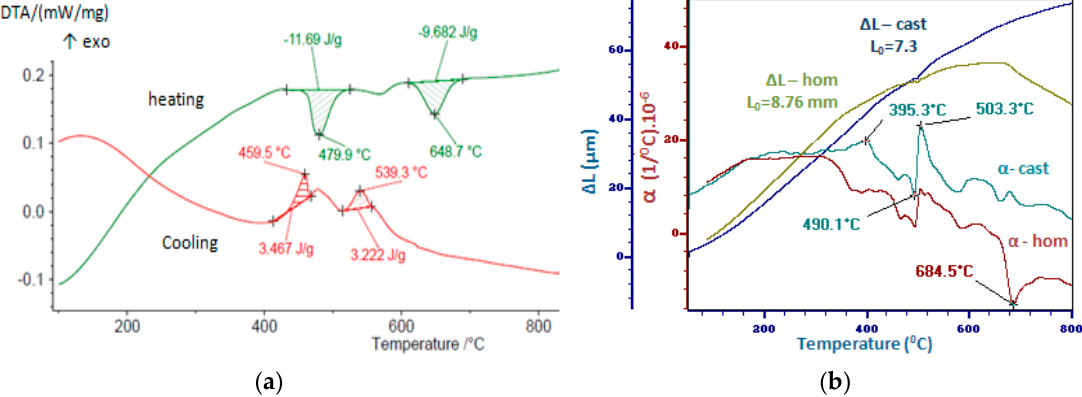
Figure 6. Thermal analysis results: ( a ) DTA curves during heating and cooling; ( b ) expansion curves ( Δ L) and variation of the physical expansion coefficient according to the temperature ( α ).